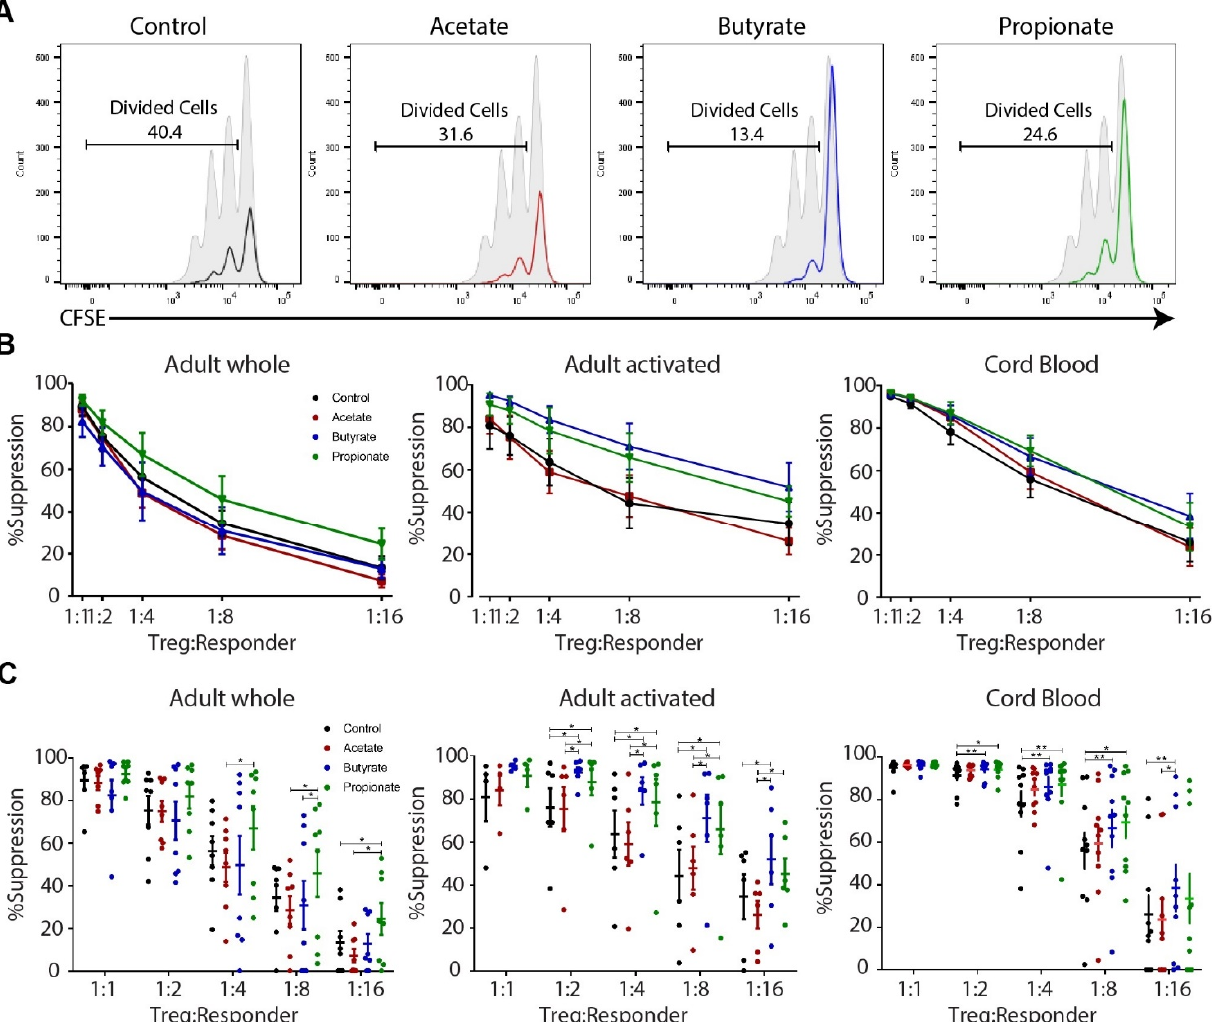
Figure 5. Short-chain fatty acids (SCFAs) enhance the suppressive capacity of in vitro induced regulatory T cells (iTregs). ( A ) Representative histograms showing the proliferation of responder cells co-cultured with iTregs differentiated under various conditions (see legends to Figure 4); data shown correspond to a suppressor/responder ratio of 1:8. ( B , C ) Percentage of suppression obtained at varying suppressor/responder ratios using the whole population (left panels; eight independent experiments) or only the population of activated (bead-selected CD25 high ; middle panels; six independent experiments) iTregs deriving from adult naïve CD4 + cells, and iTreg cells deriving from cord blood naïve CD4 + cells (right panels; ten independent experiments) differentiated under various conditions (see legends to Figure 4). The data are given as means with the standard error of the mean (SEM). Friedman test with Dunn’s multiple comparisons (post hoc) was used for statistical analysis. * p < 0.05, ** p < 0.01.